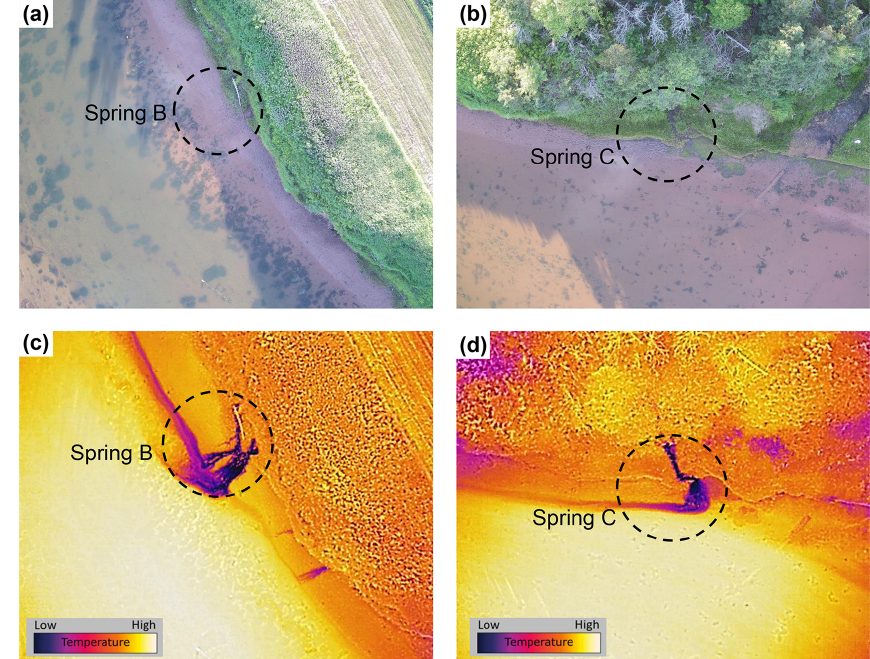
Figure 4. (a, b) Visual drone images of two of the springs that were manually gauged (Springs B and C; see Table S2). (c, d) Corresponding thermal images from the drone’s thermal sensor. Scales are not equal among panels: there was a maximum thermal offset of 16 and 12 ◦ between the spring water and receiving environment for (c) and (d) , respectively. Pixel resolutions were 6.0 and 5.2cm per pixel for panels (c) and (d) ,